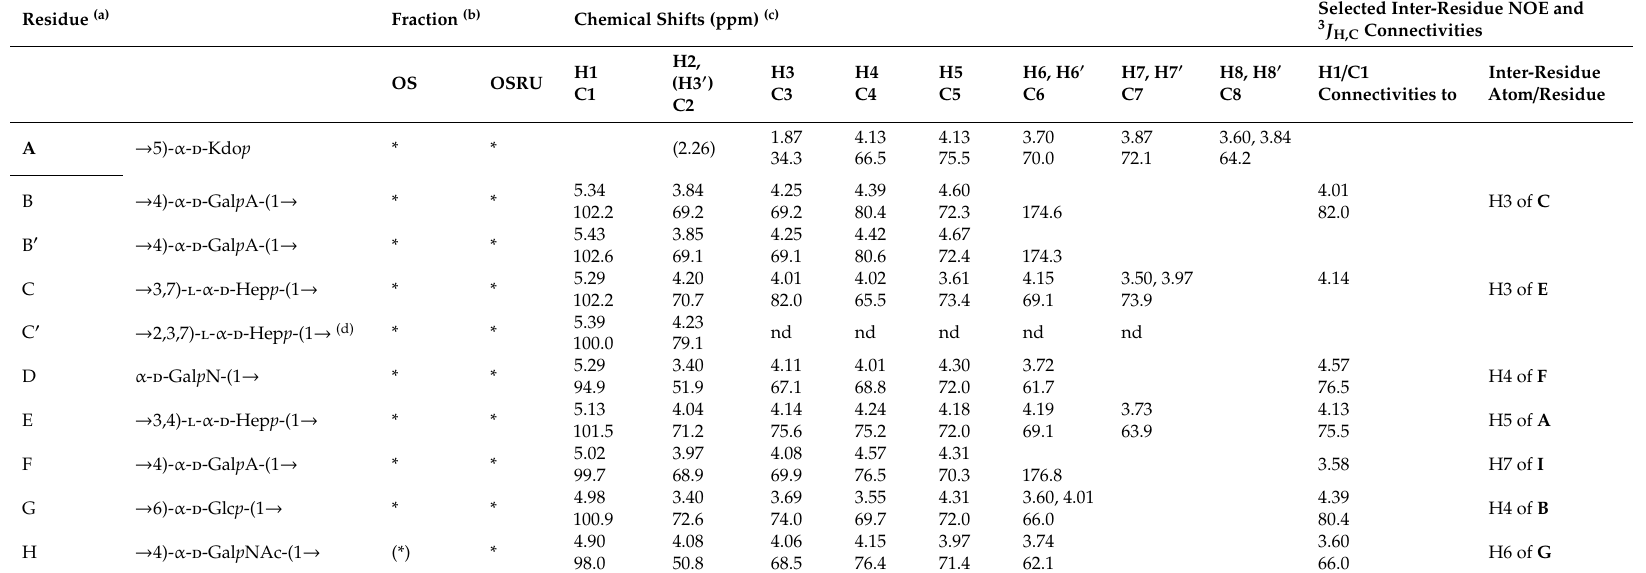
Table 1. The 1 H and 13 C NMR chemical shifts and selected inter-residue correlations from NOESY and HMBC spectra of the OS and OSRU fractions isolated from P. shigelloides 90 / 89